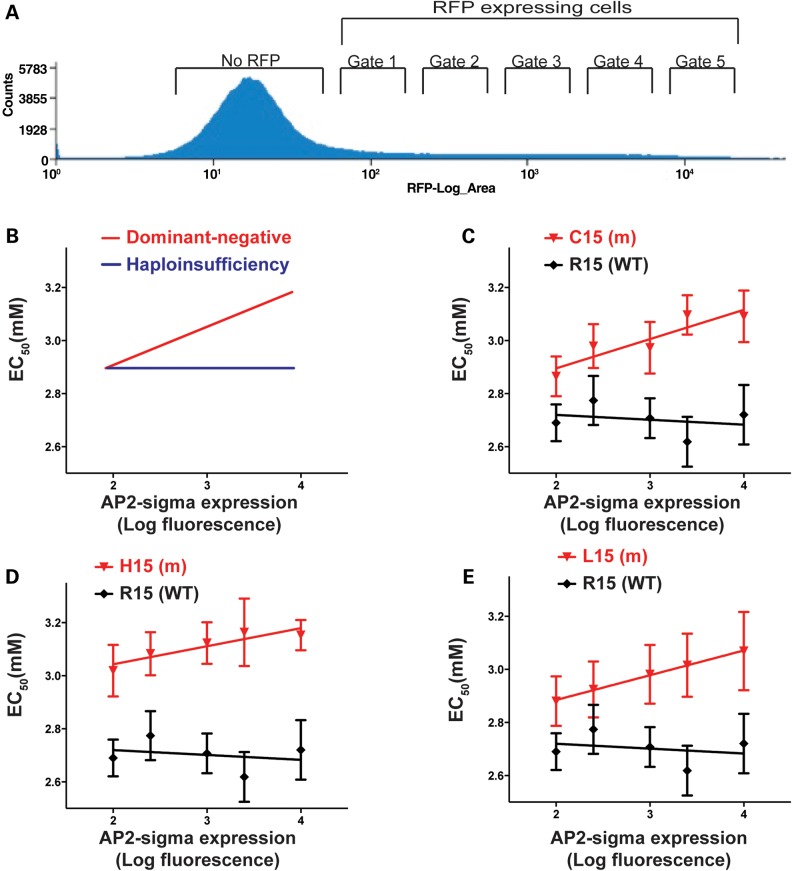
Comparison of EC50 values for HEK-CaSR cells transfected with increasing amounts of wild-type (WT) or mutant AP2S1-pBI-CMV4-RFP expression constructs. (A) During flow cytometry, fluorescence over a 1–10 000 range can be detected. The first large peak represents cells not expressing RFP but displaying low levels of auto-fluorescence. Cells displaying increased fluorescence with respect to this population reflect those expressing RFP. Cells from five different RFP fluorescences were selected on the basis of mean fluorescence (gate 1 log mean fluorescence = 50–100, gate 2 log mean fluorescence = 125–250, gate 3 log mean fluorescence = 500–1000, gate 4 log mean fluorescence = 1250–2500 and gate 5 log mean fluorescence = 5000–10000), consistent with a fluorescence ranging from between 1- and 100-fold over baseline, i.e. between gate 1 and gate 5, which represent the lowest and the highest levels of RFP fluorescence, and therefore AP2σ2, respectively. (B) Predicted linear regressions of mean EC50 with effects owing to dominant-negative and haploinsufficiency mutants. Loss-of-function mutants with dominant-negative effects on the WT protein will exert greater effects on EC50 values with increasing concentrations (red line), whereas loss-of-function mutants associated with haploinsufficiency of the WT protein will not affect the EC50 values with increasing concentrations as the EC50 will depend on the concentration of WT protein, which will remain constant (blue line). (C–E) Linear regression of the mean EC50 of cells with increasing levels of AP2σ2 expression demonstrate no significant deviation from zero in cells transfected with the WT-R15 AP2S1-pBI-CMV4-RFP expression construct (r2 = 0.07, P = 0.67), whereas a significantly positive incline to the slope is observed in cells transfected with the mutant AP2S1-pBI-CMV4-RFP expression constructs (C15 r2 = 0.82, P < 0.05; H15 r2 = 0.84, P < 0.05; L15 r2 = 0.99, P < 0.0001), thereby indicating that FHH3-associated AP2σ2 mutations may act in a dominant-negative manner. All experiments were conducted on N = 8 separate occasions.